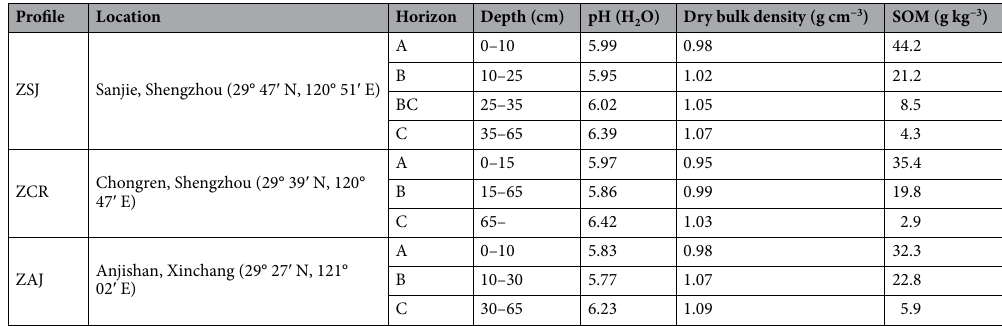
Table 1. Selected physicochemical properties of the studied soil profiles.